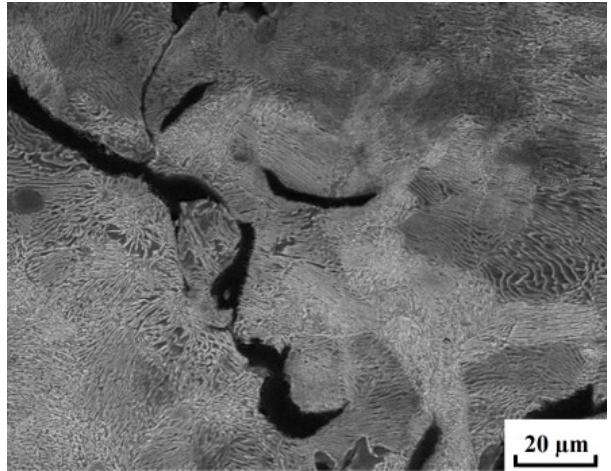
Figure 3. Microstructure of the grey cast iron .